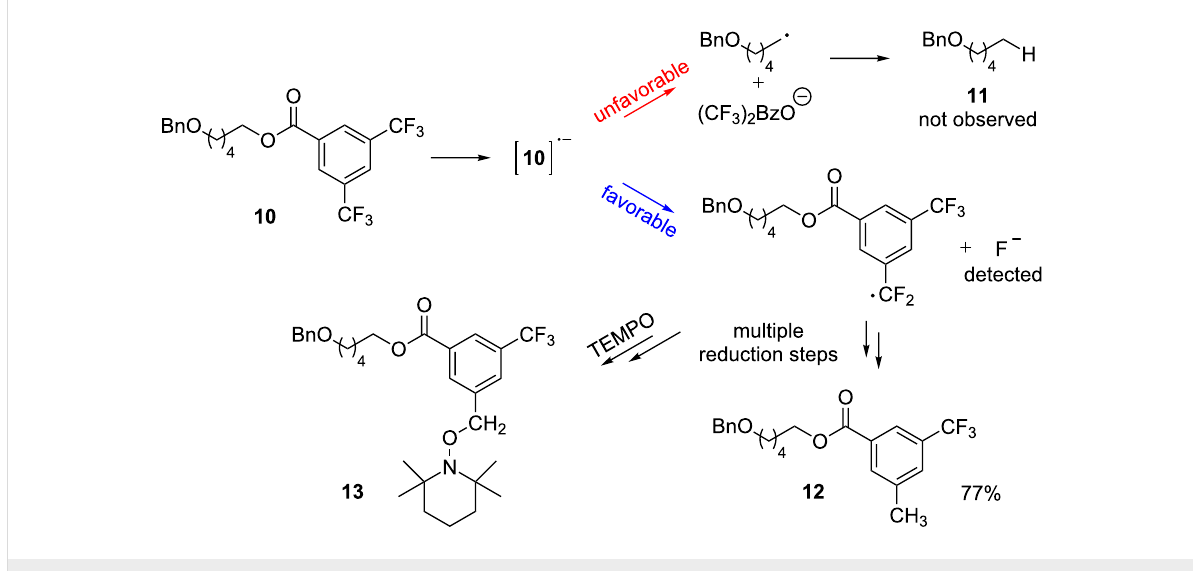
Scheme 7: Reduction of benzoate moiety in case of non-benzylic alcohols.